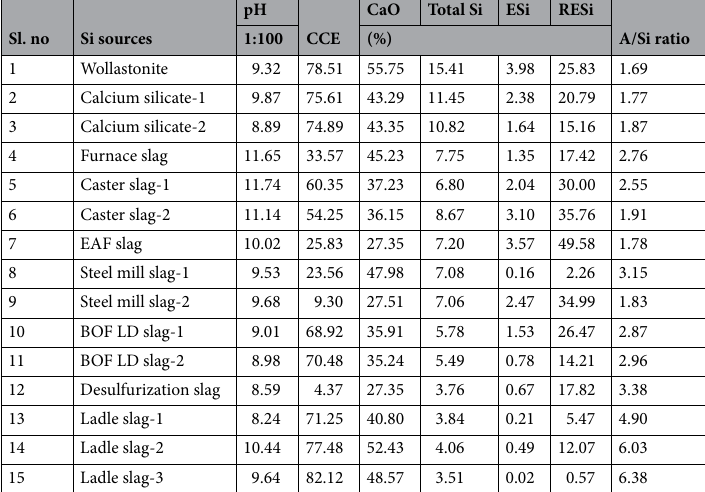
Table 1. Chemical properties of silicate slags used in the study.